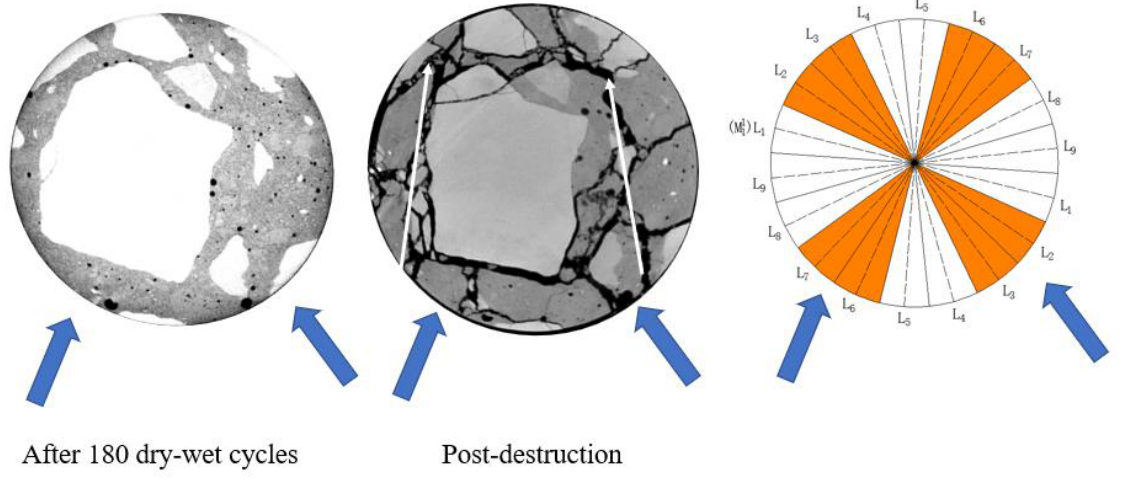
Figure 11. Comparison of damage classification and crack distribution of protected group H 1 meas- uring surface. measuring